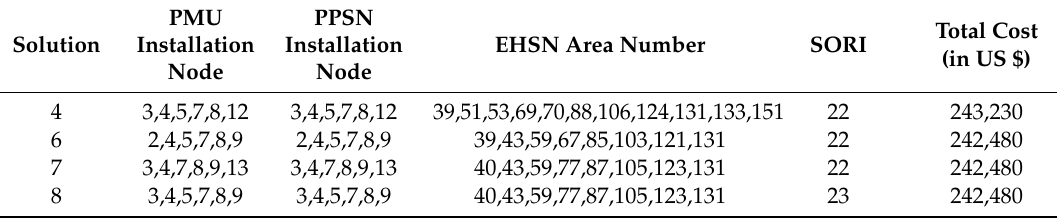
Table 3. Optimization problem result. PPSN, plug-in powered sensor node; EHSN, energy harvesting sensor node.